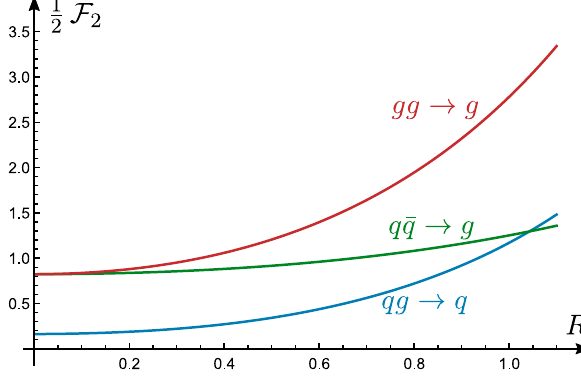
Fig. 3 Two-loops CLs coefficient as a function of jet radius R in the k t and C–A algorithms for the three channels